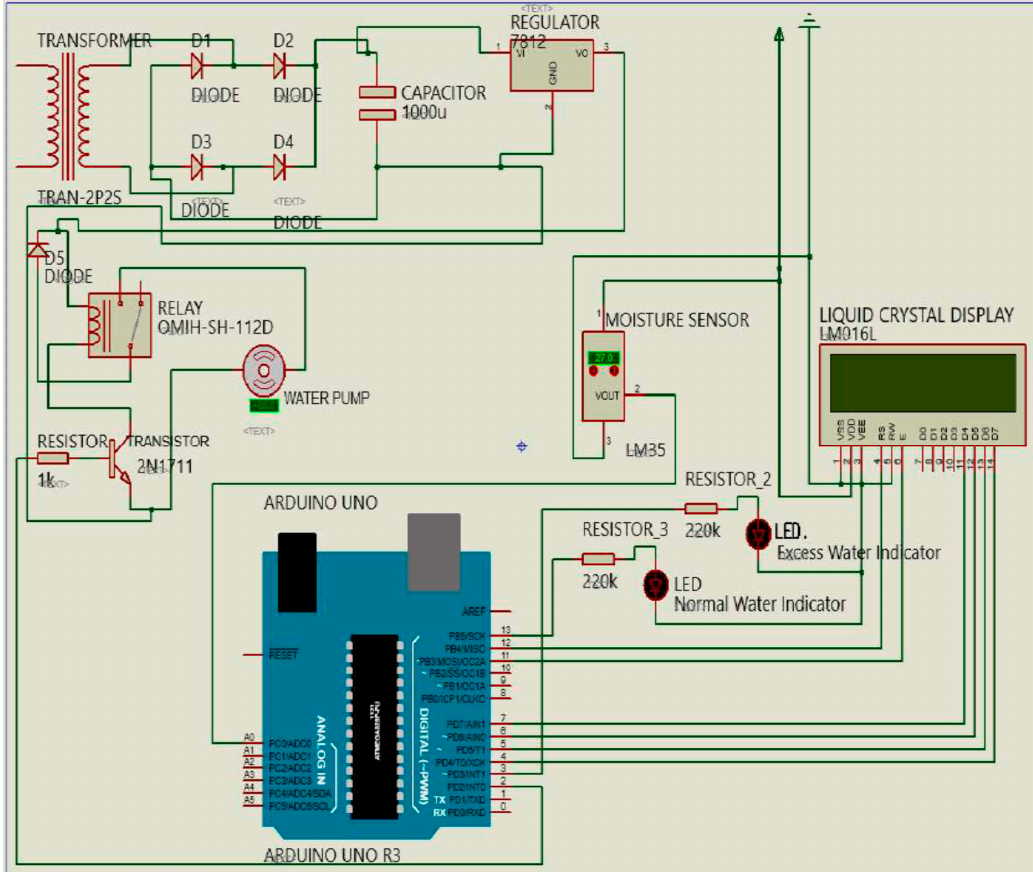
Figure 3. Schematic diagram of a smart irrigation modeling and simulation system.